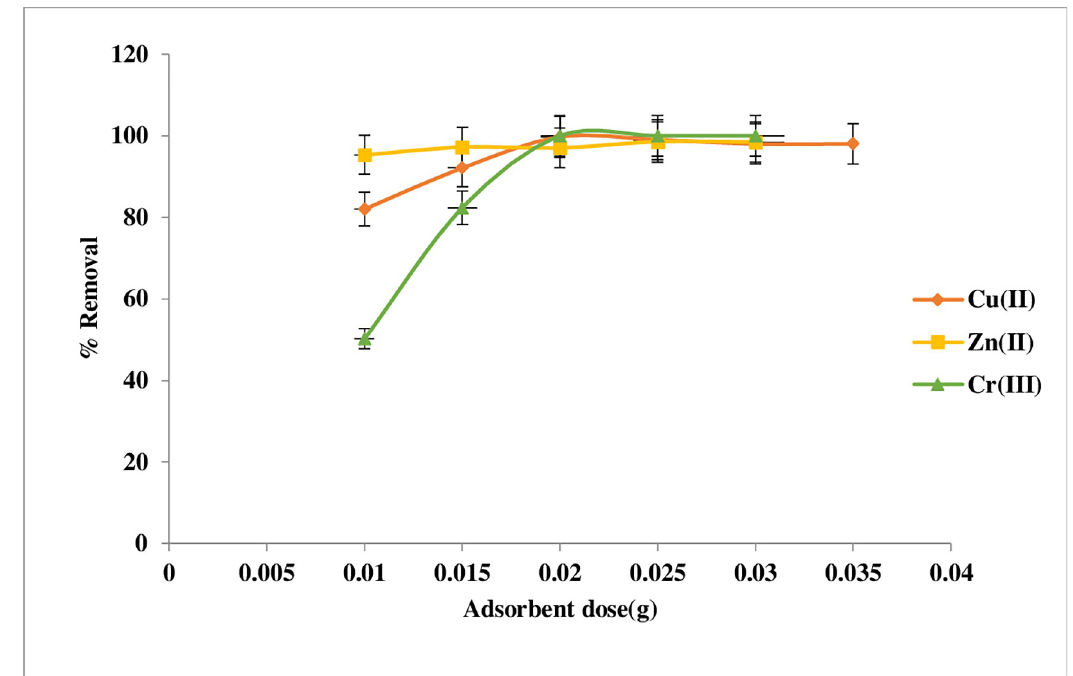
Fig 9. The effect of adsorbent dosage on the adsorption Cu(II), Zn(II), and Cr(III) by Imine.